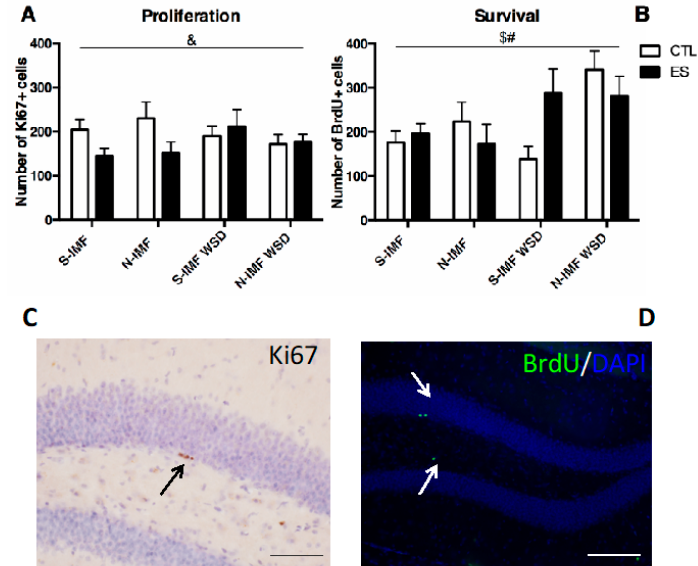
Figure 5. Dietary exposures modulate the e ff ect of ES on neurogenesis. ES modulated the e ff ect of WSD on levels of proliferating cells as measured by Ki67 + cells ( A ). WSD increased survival of newborn neurons and ES interacts with N-IMF in a ff ecting the survival of newborn neurons ( B ). Statistical analyses were performed using three-way ANOVA. & interaction e ff ect of condition and adult diet, p < 0.05; # interaction e ff ect of condition and postnatal diet, p < 0.05; $ significant e ff ect of adult diet, p < 0.05. Representative images of ( C ) immunohistochemistry for Ki67 + cells indicated by the black arrows and ( D ) immunohistochemistry for DAPI (blue) and BrdU (green) illustrating BrdU + cells indicated by the white arrows in the hippocampal dentate gyrus. Scale bar: 100 µ m in C and 200 µ m in